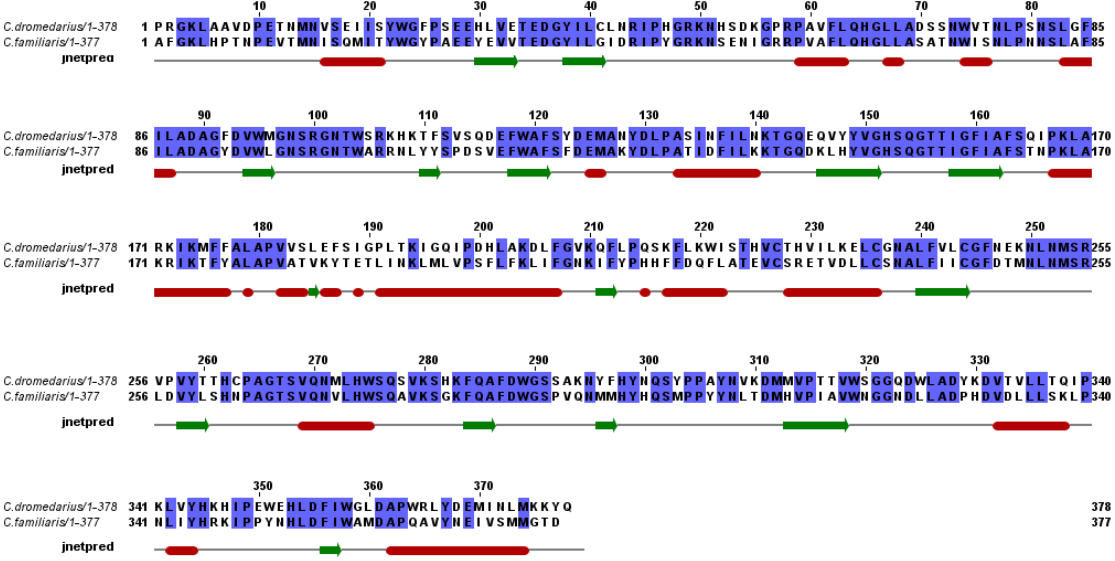
Figure 5. The secondary structure annotation sites of the cLIPA and dGL sequences using Jalview program [19] . Red cylinders and green arrows indicated helix and β -sheet,